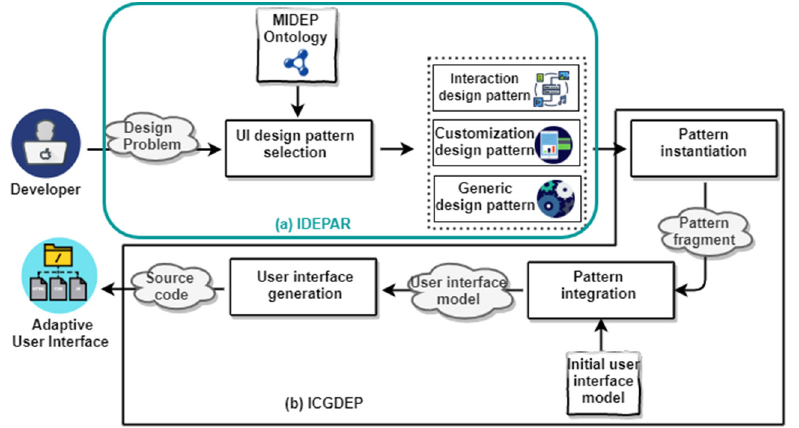
Figure 1. IDEPAR system within the AUIDP framework ( a ) IDEPAR system, ( b ) ICGDEP system.